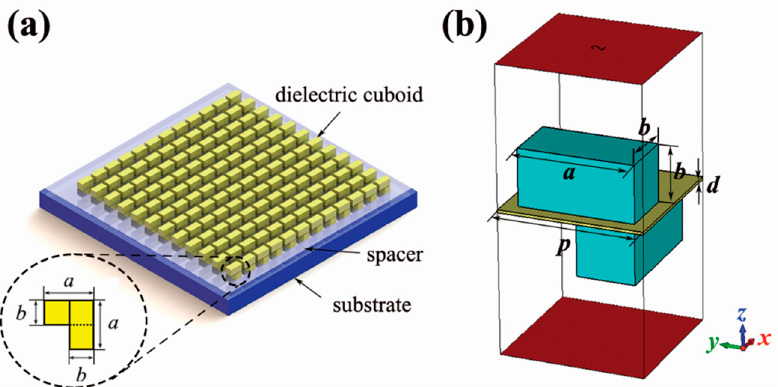
Figure 1. ( a ) Schematic diagram of the proposed chiral metamaterial. The inset illustrates the relative position of two orthogonal cuboids in the metamolecule. ( b ) Simulation settings of the unit cell. The geometrical parameters are: a = 4 mm, b = 2 mm, p = 5 mm, and d = 0.1 mm. The receiving and the transmitting ports are in red color.